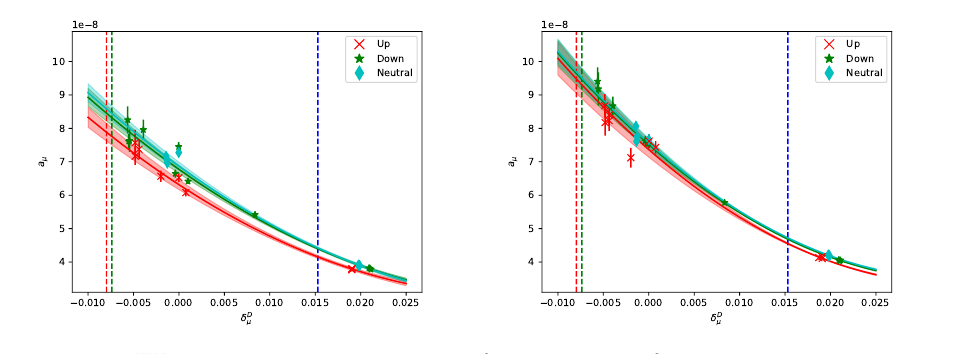
Figure 2: a HVP against Dashen mass, left : 32 3 × 64, right : 48 3 × 96. Note that points are µ shifted to δ m = δ m phys line. Colours refer to quarks with different charges, red : Up quark, green : Down/strange quarks, cyan : ‘Neutral’ quark. Vertical lines mark the physical quark mass